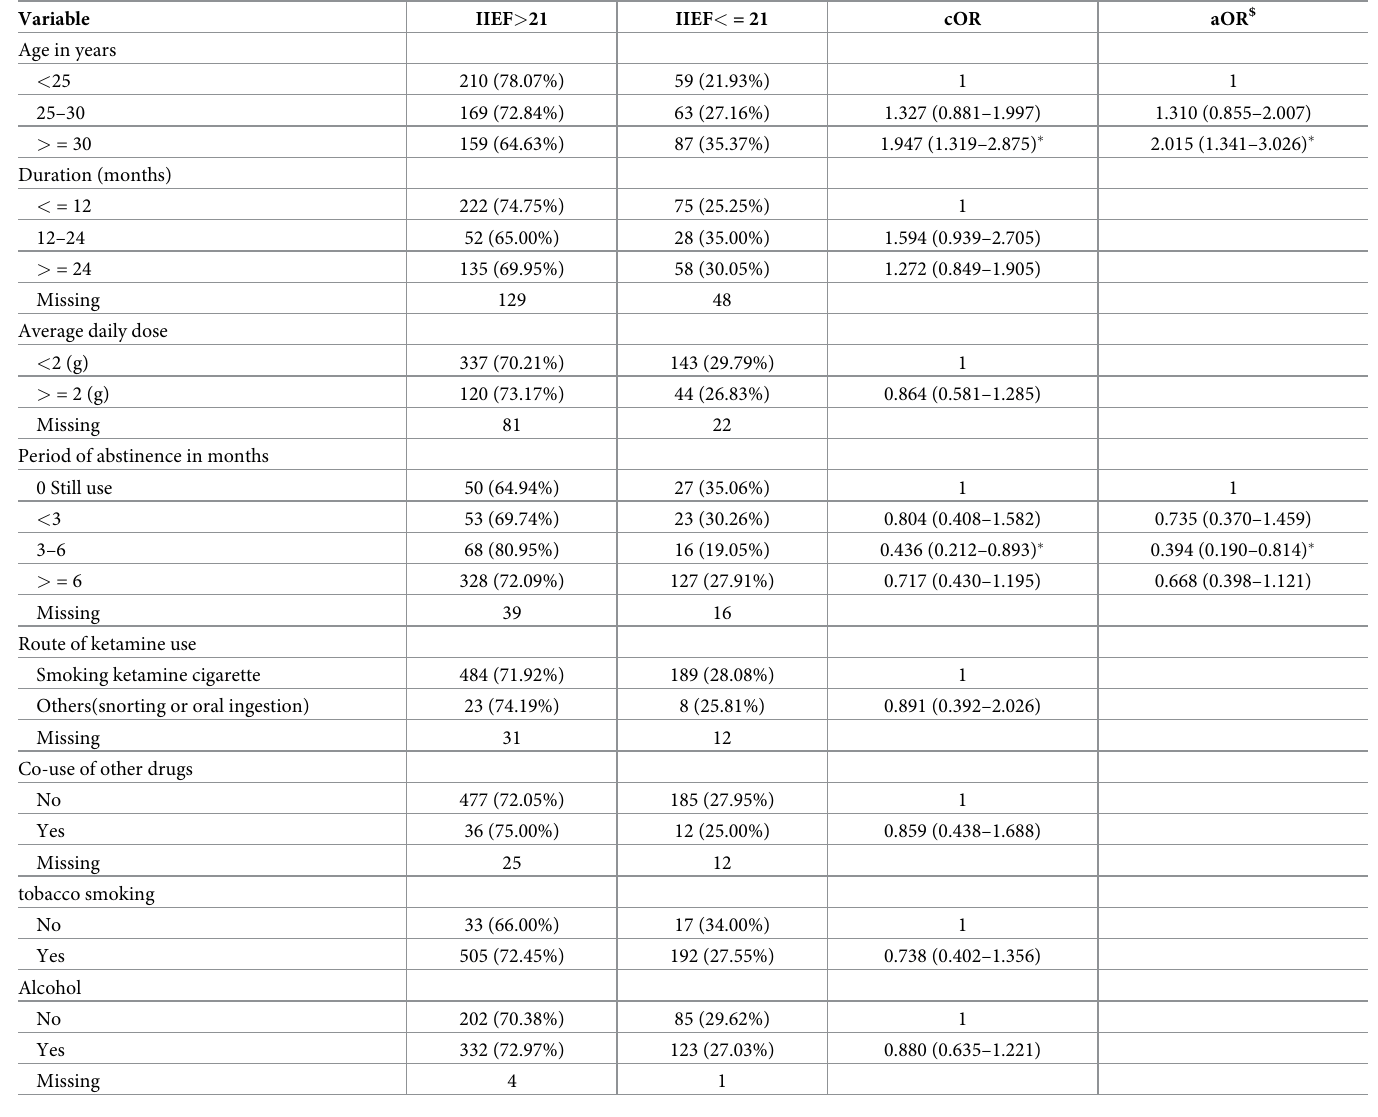
Table 4. Risk factors of IIEF < = 21 among only street ketamine